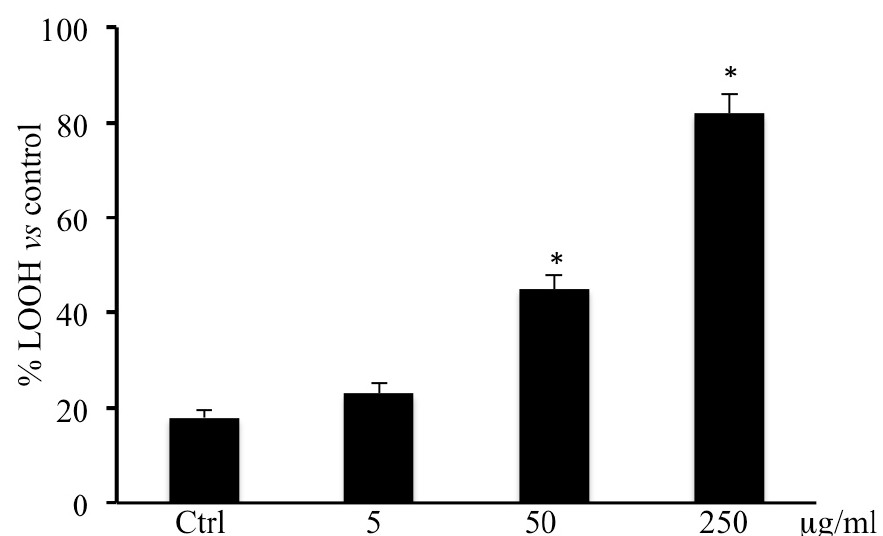
Figure 4. LOOH levels in CaCo2 cells untreated and treated for 72 h with methanolic extract of B. etnensis Raf. at di ff erent concentrations (5–250 µ g / mL). Values are the mean ± SD of four experiments in triplicate. * Significant vs. untreated control cells: p < 0.001.